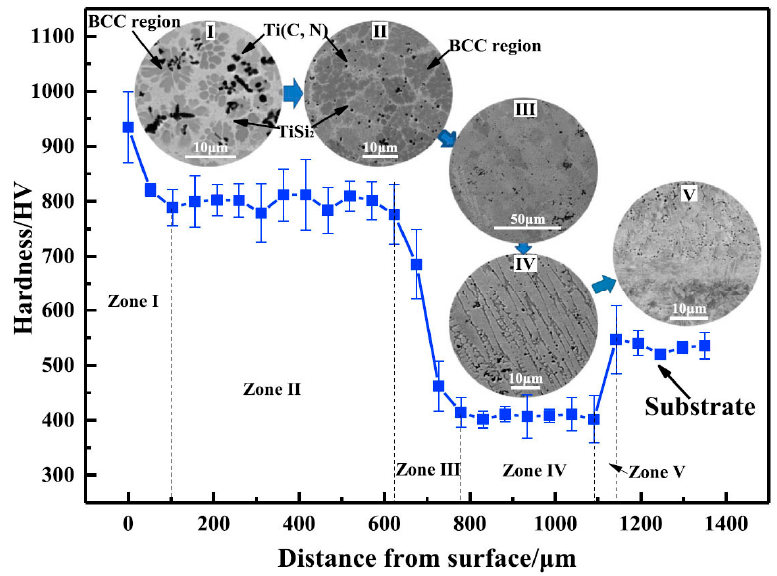
Figure 20. The HEA gradient coating: the hardness depth profile. The microstructures are placed at corresponding depth. The meaning of Zones I to V is explained in the text. Reprinted with permission from Ref. [95]. Copyright 2021 Elsevier.